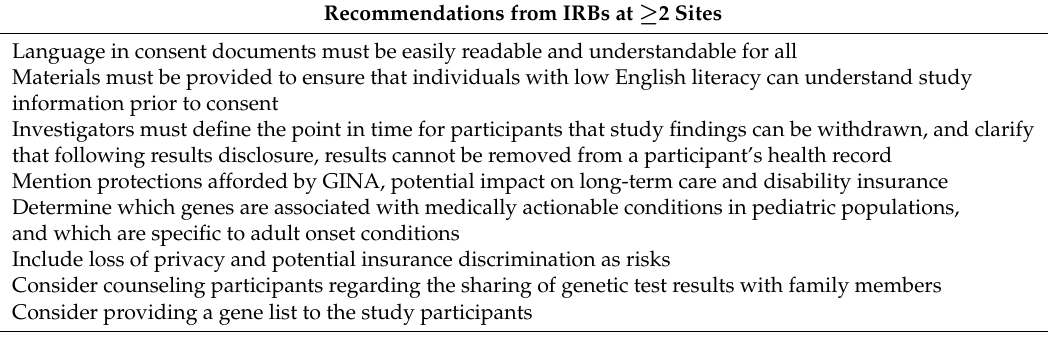
Table 3. Summaries of Institutional Review Board (IRB)